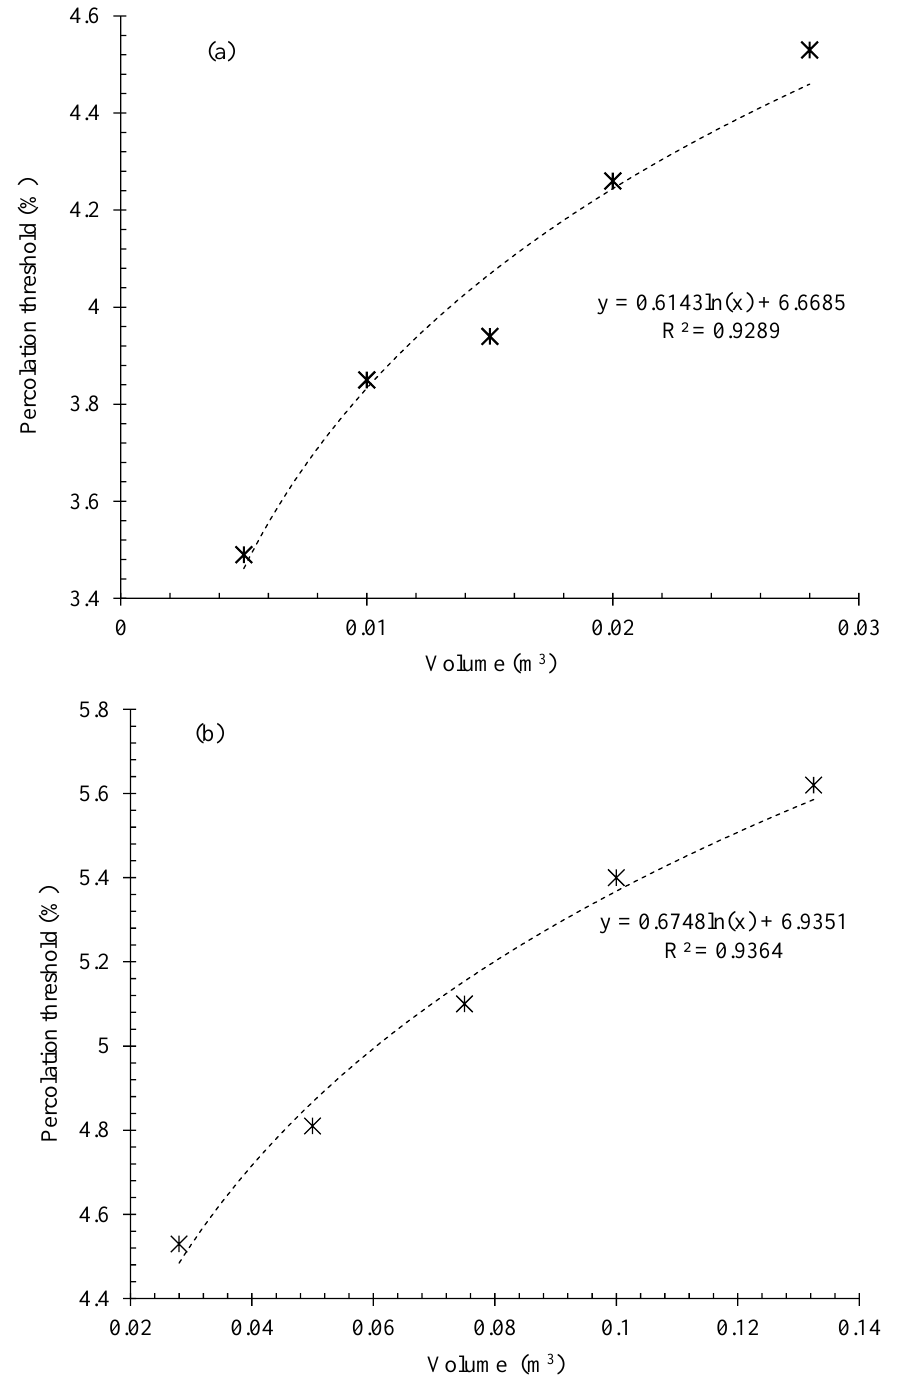
Figure 11. Relation between electrical percolation threshold and matrix volume for CNT/GNP reinforced specimens with: ( a ) different width, ( b ) different thickness.